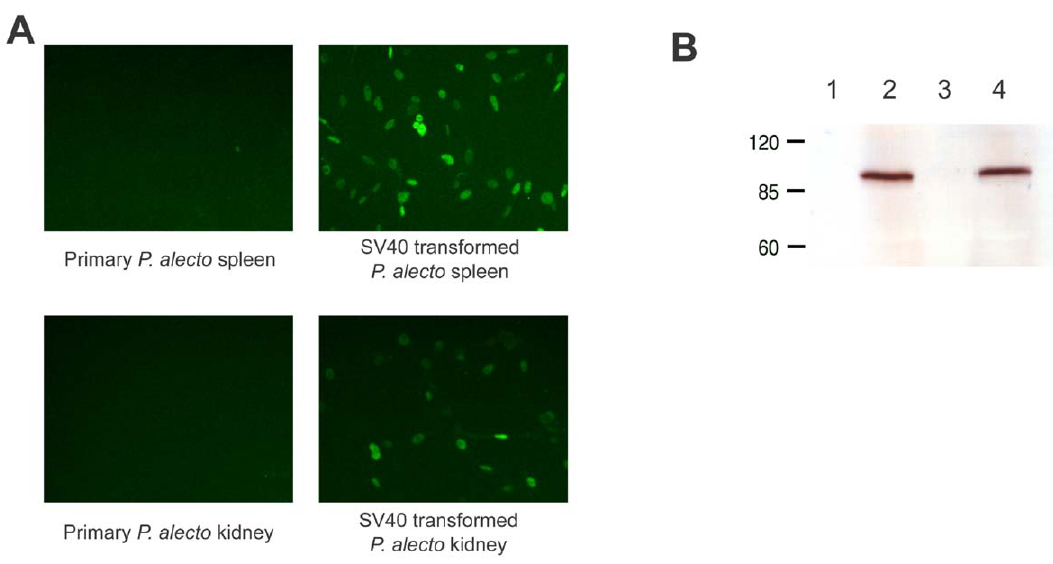
Figure 2. Stable expression of SV40T proteins in transformed cells. (A) Immunofluorescent staining of P. alecto spleen and kidney primary cells and cells transformed to detect expression of the SV40T antigens. (B) Western blot of untransformed P. alecto spleen and kidney primary cells (lanes 1 and 3, respectively) and transformed cells (lanes 2 and 4) to detect expression of the SV40 large T antigen.